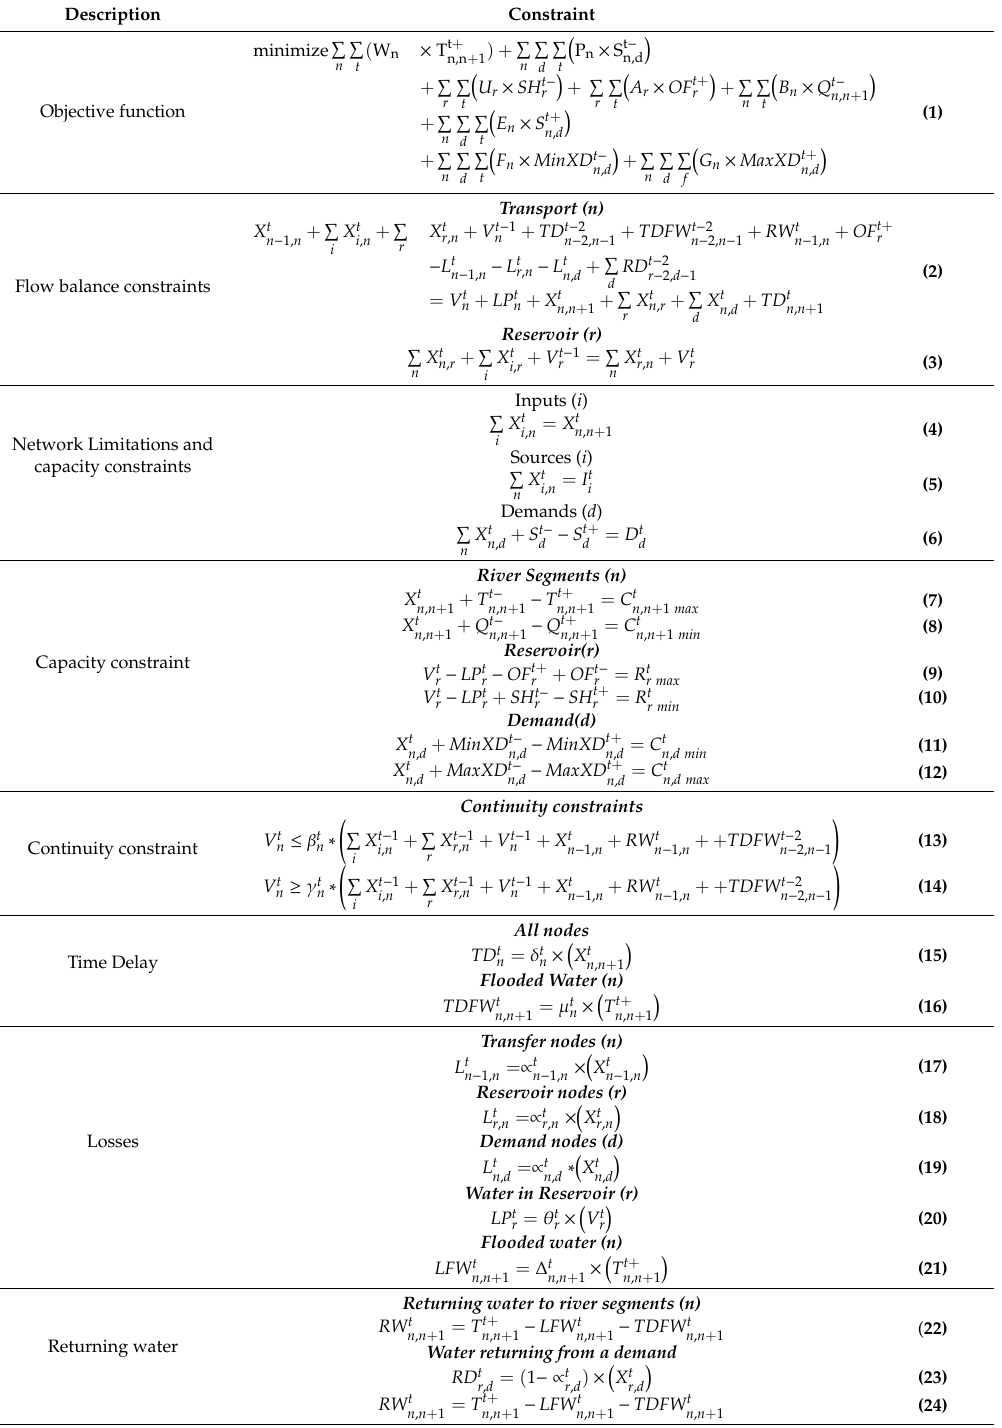
Table 2. Objective function and constraints from the linear programming